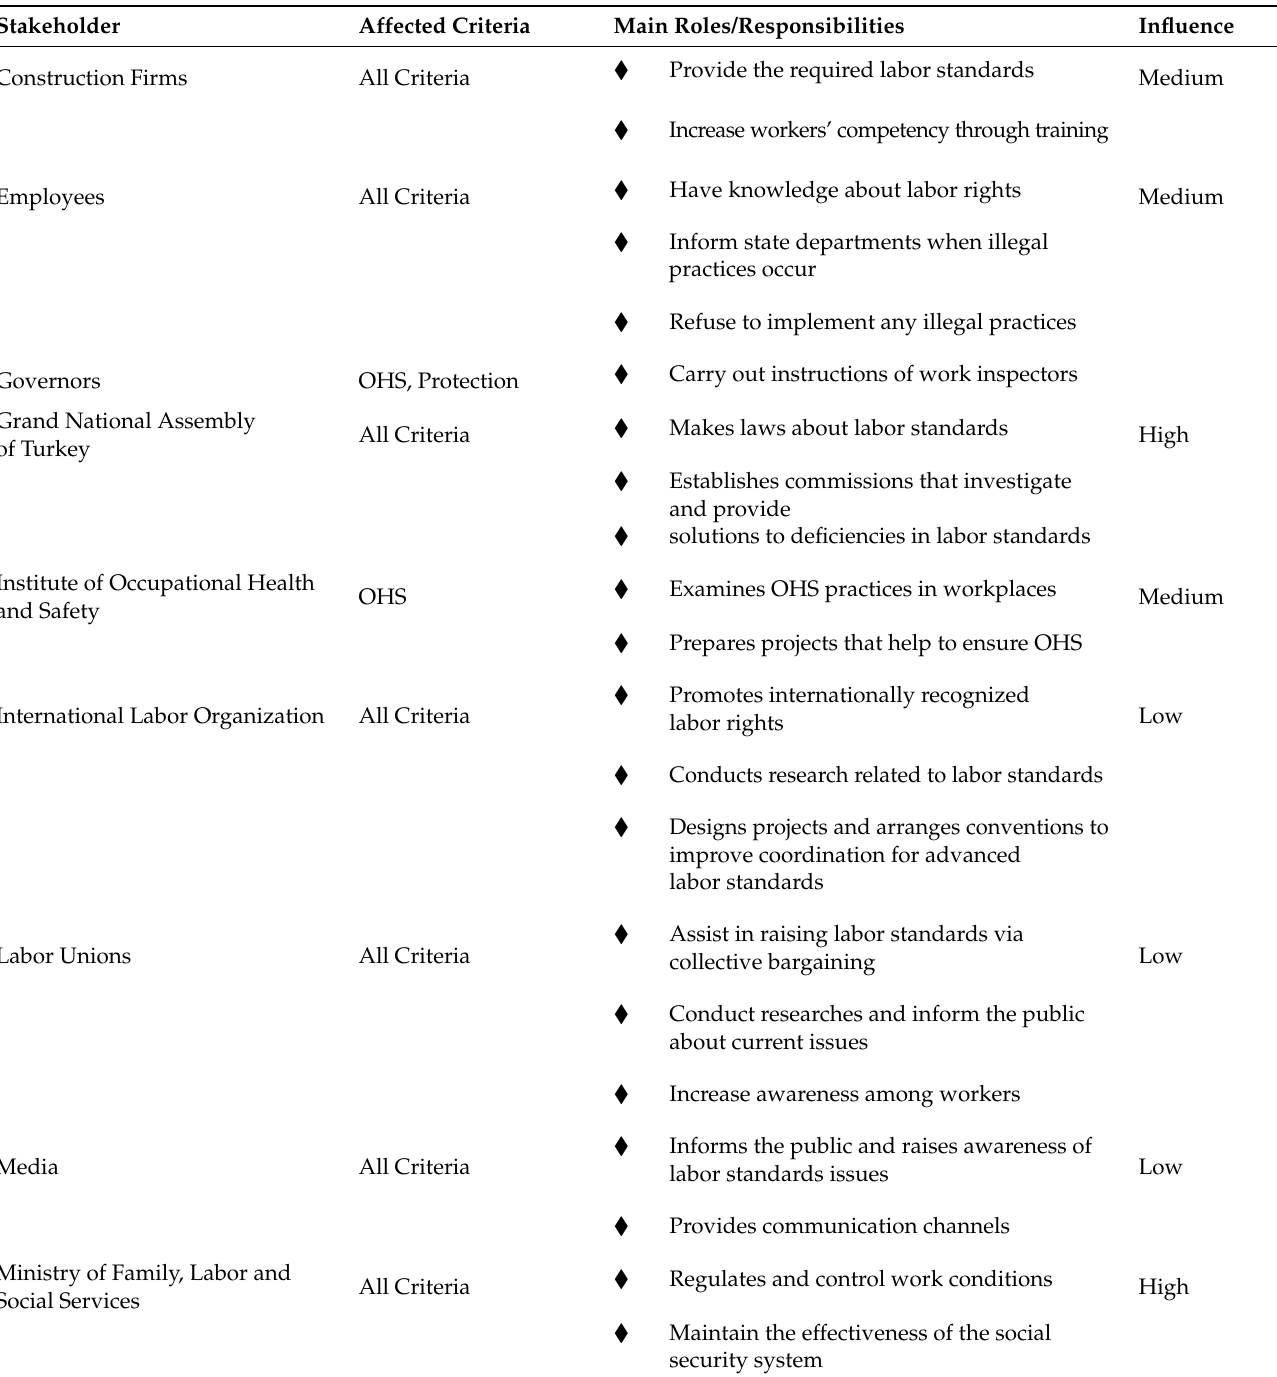
Table 2. Roles and Responsibilities of Sector